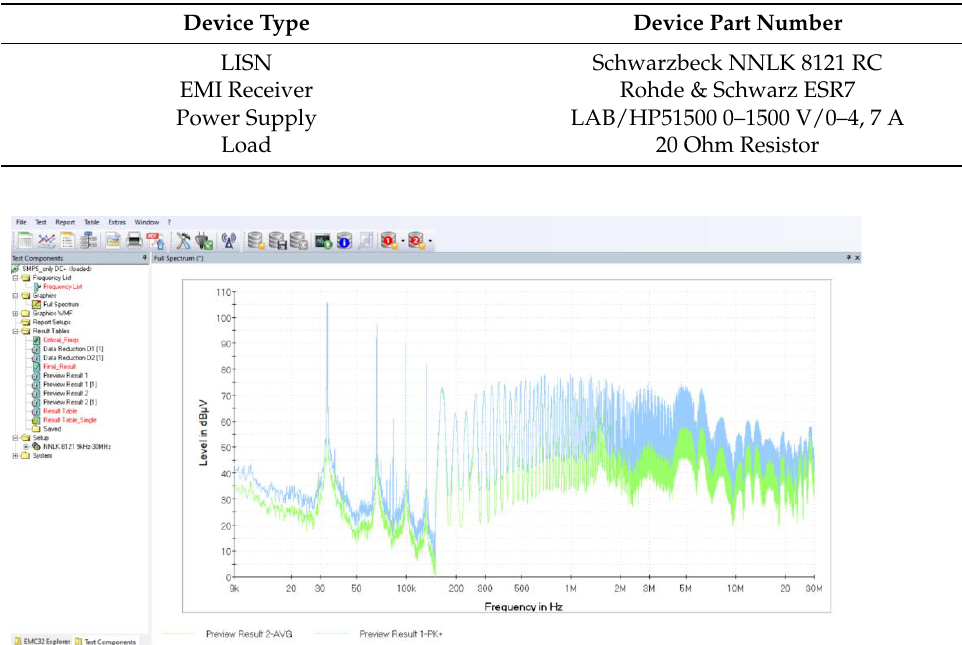
Figure 24. Comparison of PK measurement (orange) and estimation (blue) for the HFSS approach. Frequency sweep 9 kHz to 30 MHz.